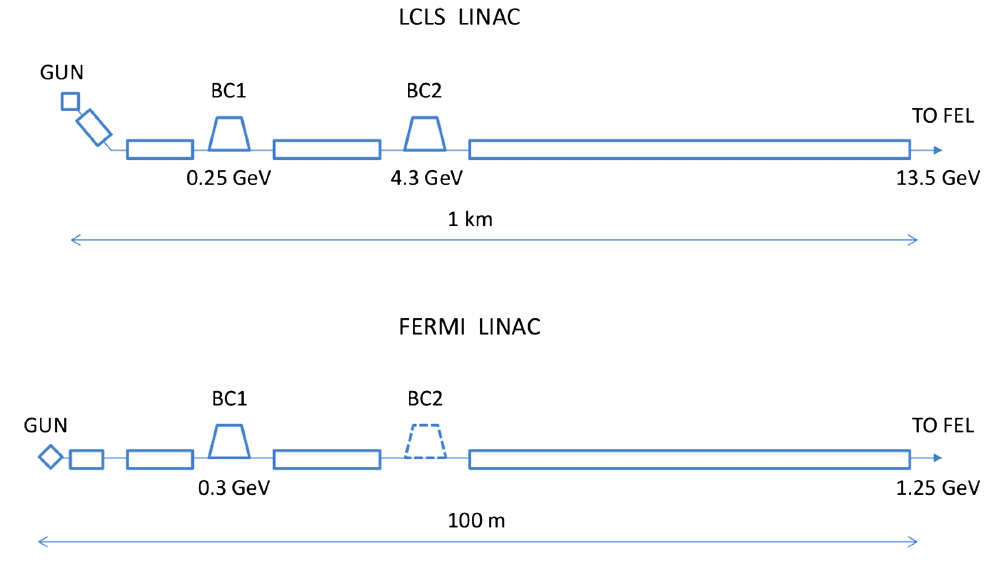
FIG. 1. Sketch of LCLS (top) and FERMI (bottom) beam lines (not in scale).